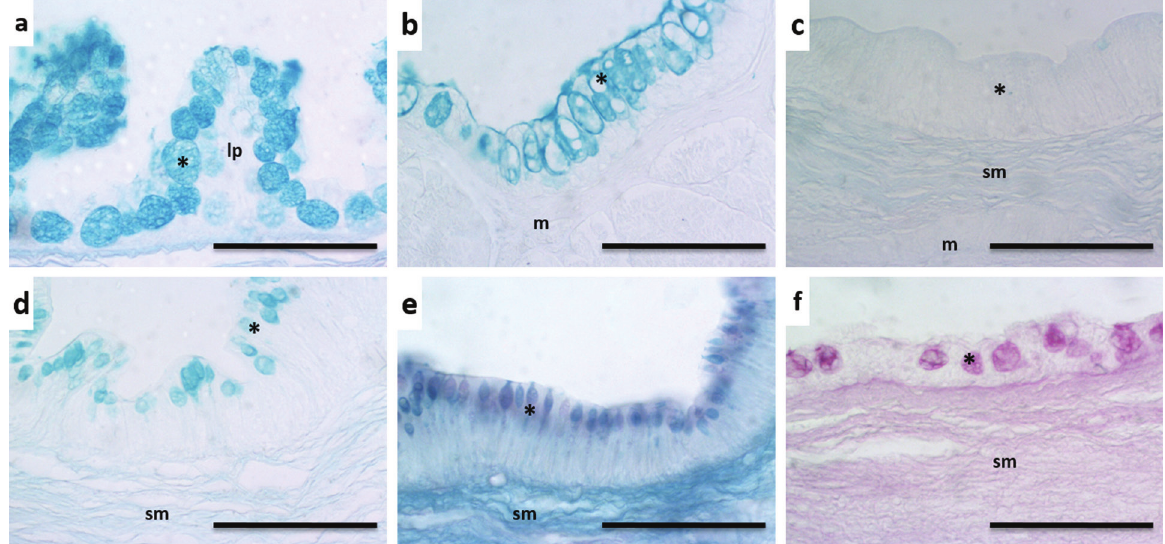
Figure 5 - Histochemical composition of glycoconjugates secreted by mucous glands of Sphoeroides testudineus . - a. Mucosa of the anteior portion of the esophagus evidencing the glands Alcian Blue-postive at pH 0.5 (*). PAS / AB 0.5. - b. Mucosa of the posterior portion of the esophagus showing glands Alcian Blue-postive at pH 0.5 (*). PAS / AB 0.5. - c. First intestinal segment with no reaction to PAS and AB. PAS / AB 0.5. - d. Second intestinal segment with goblet cells positive for Alcian Blue at pH 2.5 (*). PAS / AB 2.5. - e . Third intestinal segment rich in PAS-positive goblet cells and Alcian Blue at pH 2.5 (*). PAS / AB 2.5. - f. Rectum evidencing mucosa with PAS-postive unicellular globular glands (*). PAS. Lamina propria (lp), submucosa (sm), muscular layer (m). Bar: 100